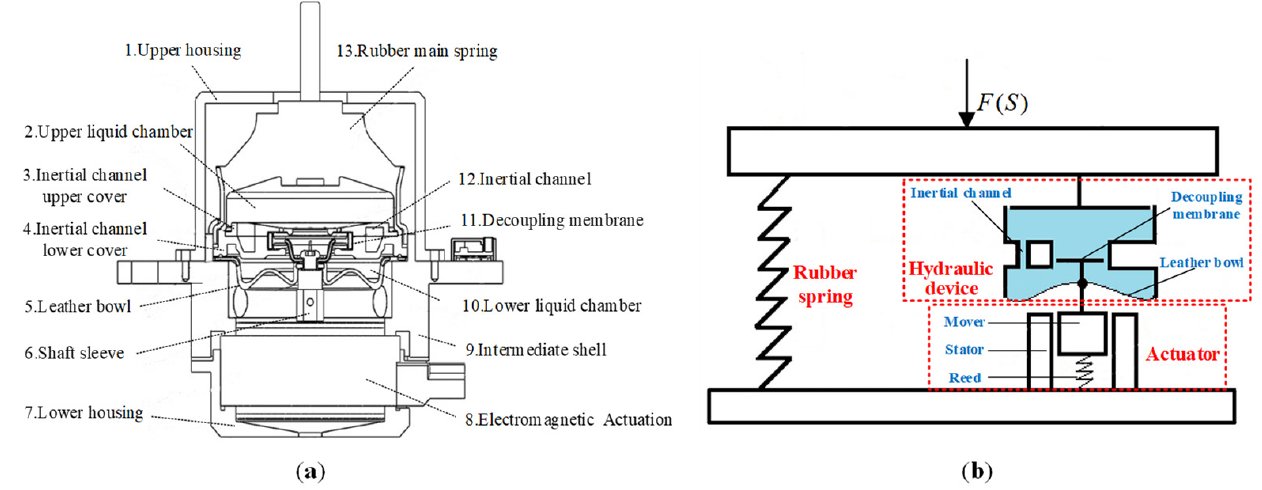
Figure 3. Electromagnetic-rubber-hydraulic integrated hybrid vibration isolator: ( a ) the physical model; ( b ) the schematic diagram. Table 1. The structural parameters and composition